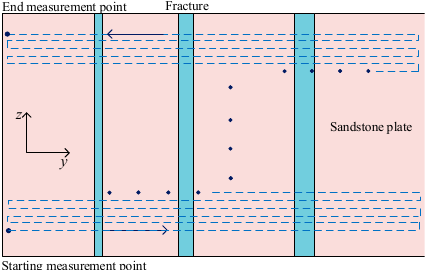
Figure 9. Schematic of the measurement method of slotted sandstone plate.